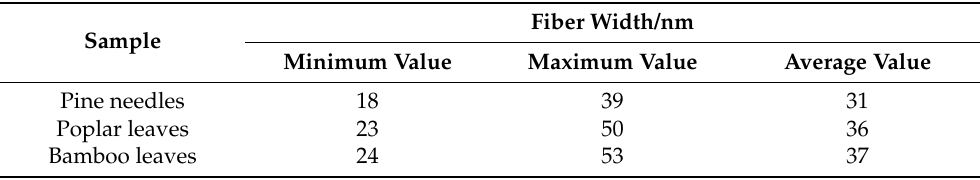
Table 2. Fiber width of CNPs prepared from leaves/needles of three species.